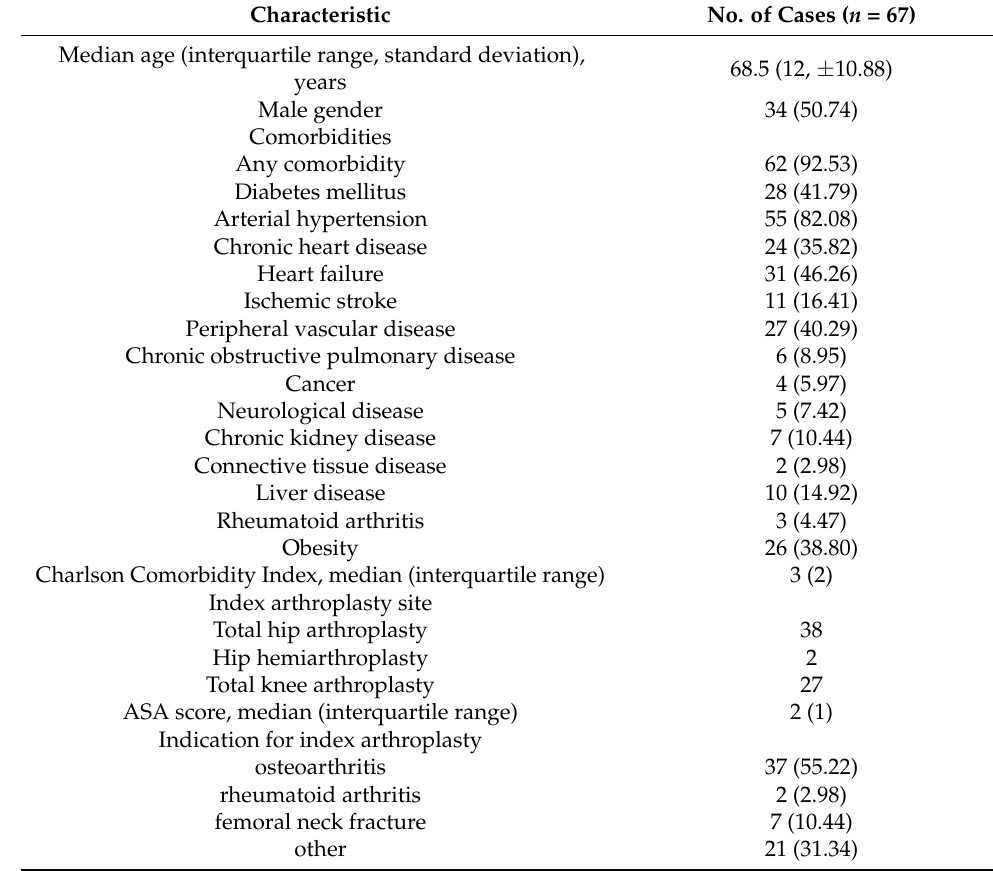
Table 2. Baseline characteristics of the enrolled patients diagnosed with PJI from 2016 through 2022.